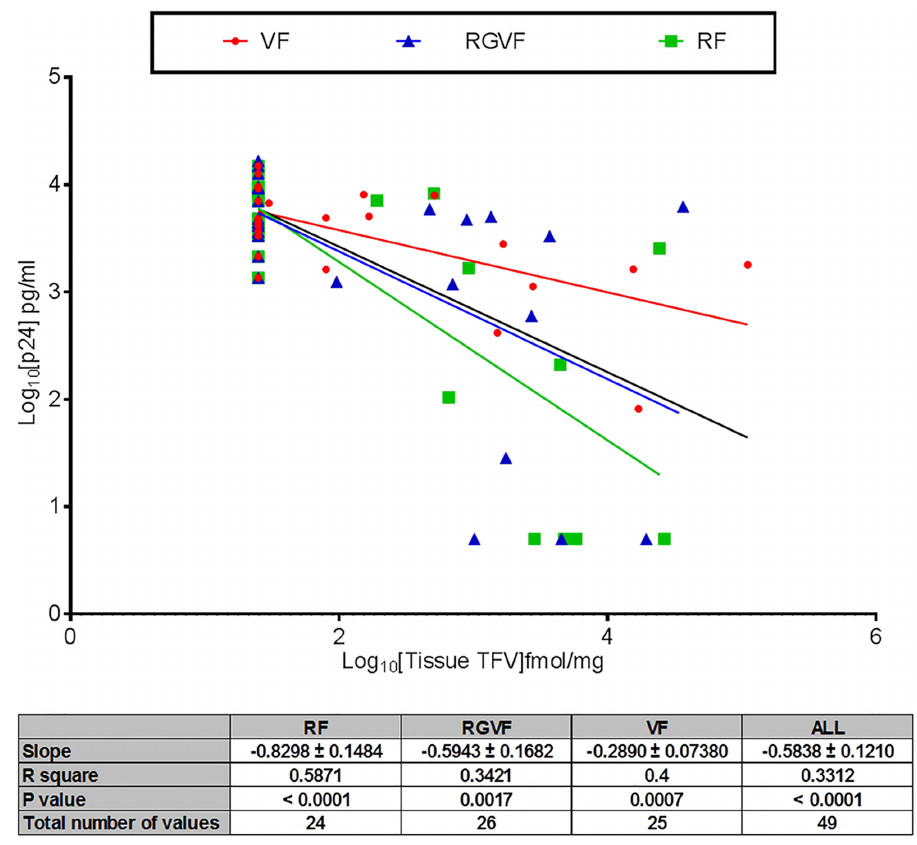
Fig 3. PK/PD relationship between rectal tissue TFV and colorectal tissue supernatant HIV-1 p24 after use of the VF TFV gel, the RGVF TFV gel, and the RF TFV gel. The black line represents PK/PD relationship for the entire data set across all three